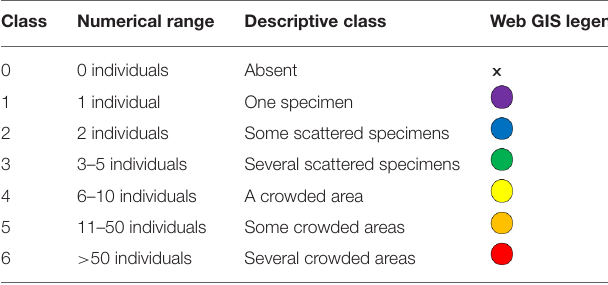
TABLE 2 | Numerical and descriptive abundance classes used to record the abundance of the target species observed during the survey.